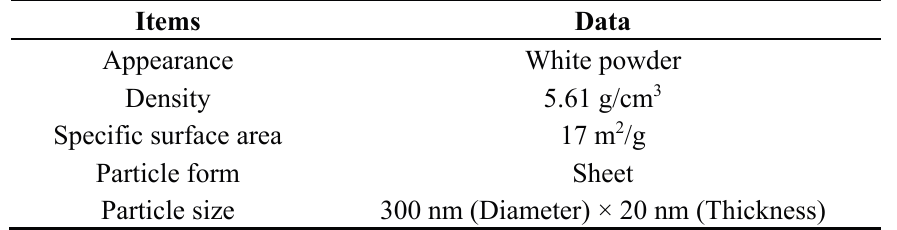
Figure 1. Schematic diagram of the meliorated multi-frequency band pyroelectric sensor (unit: μ m). Table 1. Material properties and geometry of commercially prepared ZnO powder.